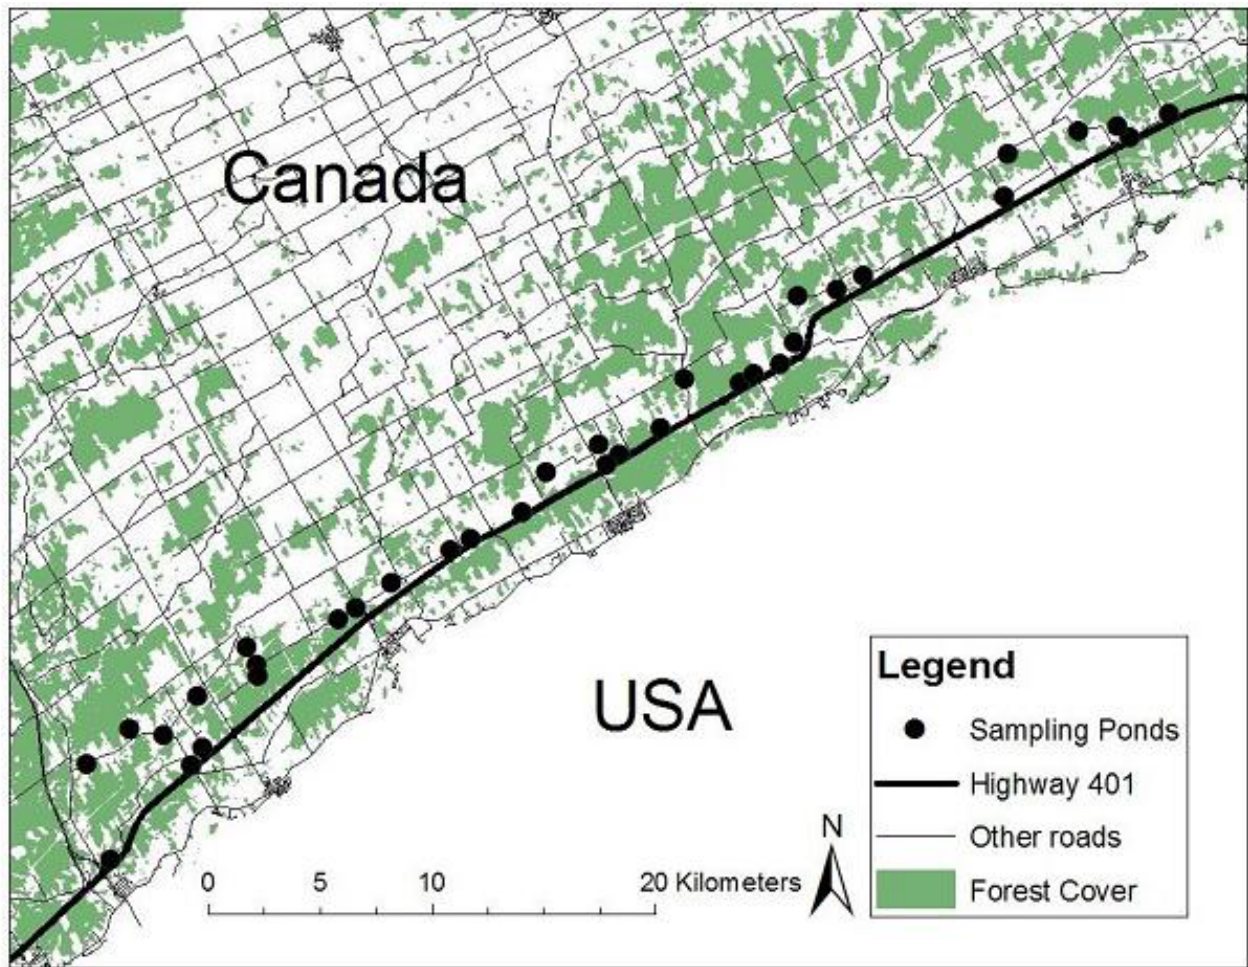
Fig. 2. Map of the study area. The area shown is located in eastern Ontario, approximately 100 km south of Ottawa and 100 km southwest of Montreal, with the St. Lawrence River forming the boundary between Canada and the